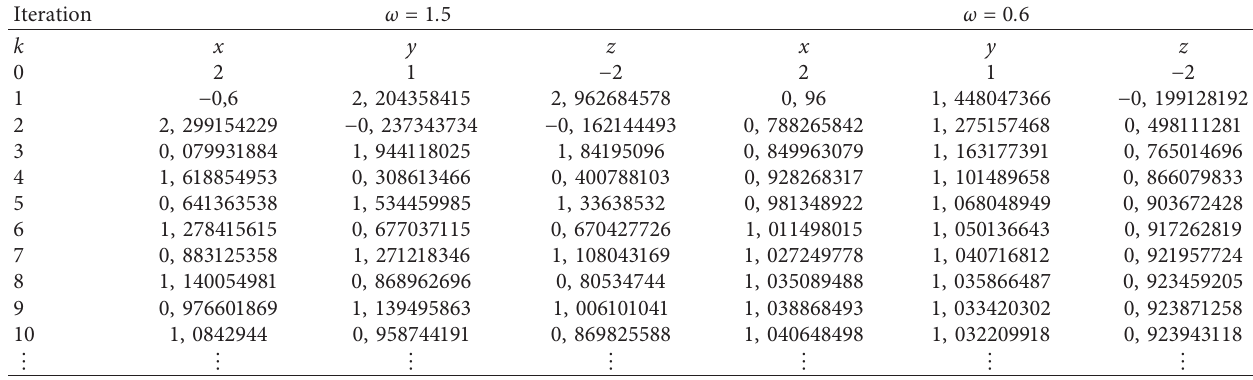
Table 1: Approximate solution of equation (35) using the proposed method (33).